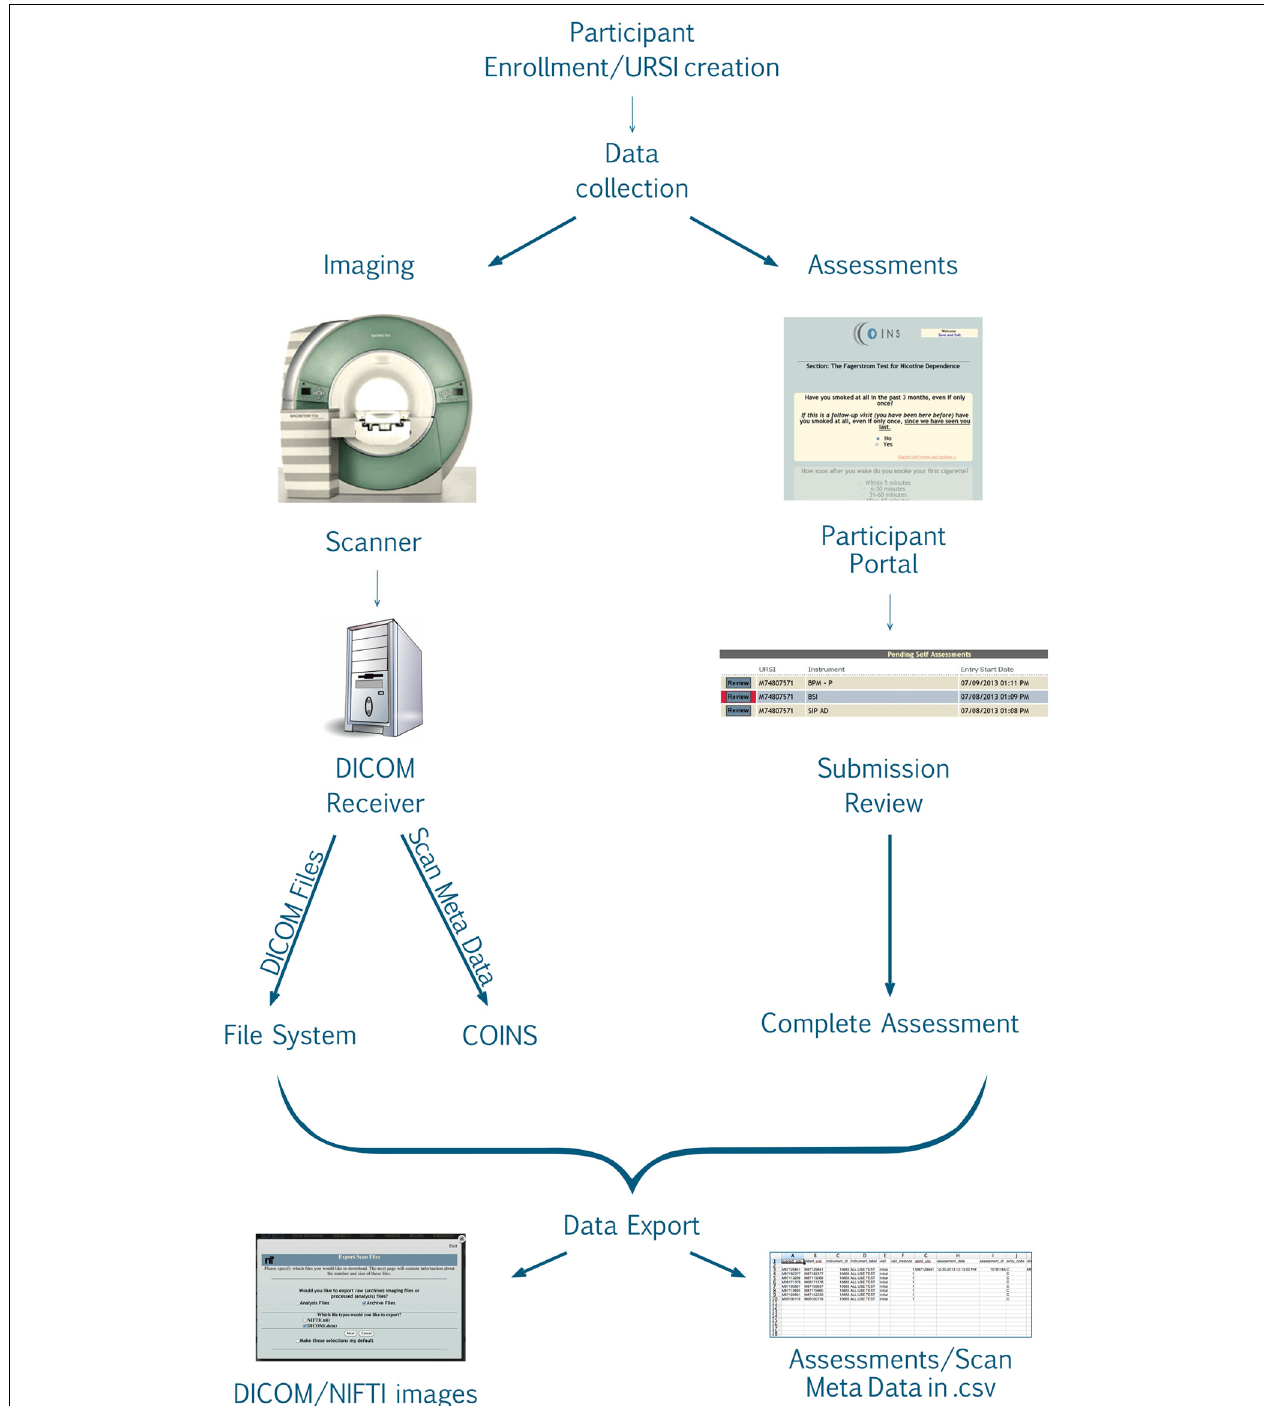
FIGURE 3 | Data collection flow